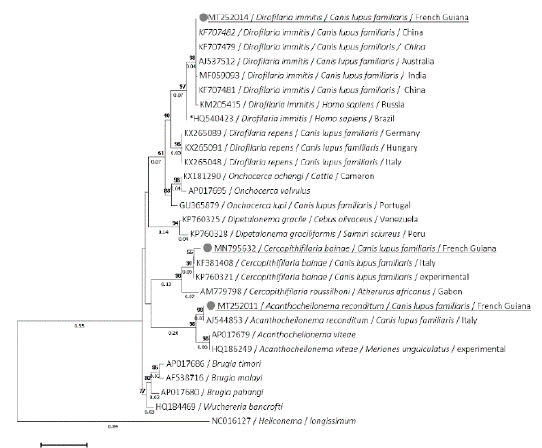
Figure 4. Phylogram of the 12S rRNA gene generated by maximum likelihood method from 29 partial (421) sequences. The tree with the highest log likelihood 5-2356.1682) is shown. A discrete Gamma distribution was used to model evolutionary rate differences among sites (5 categories (+G, parameter = 0.6437)). Numbers above and below branches are the display of bootstrap replicate values and branches length, respectively. Host, geographical location (when available) and GenBank accession number are indicated in each node. The sequences of the present study are underlined. *: indicates the most virulent strain of D. immitis from Latin America [39].